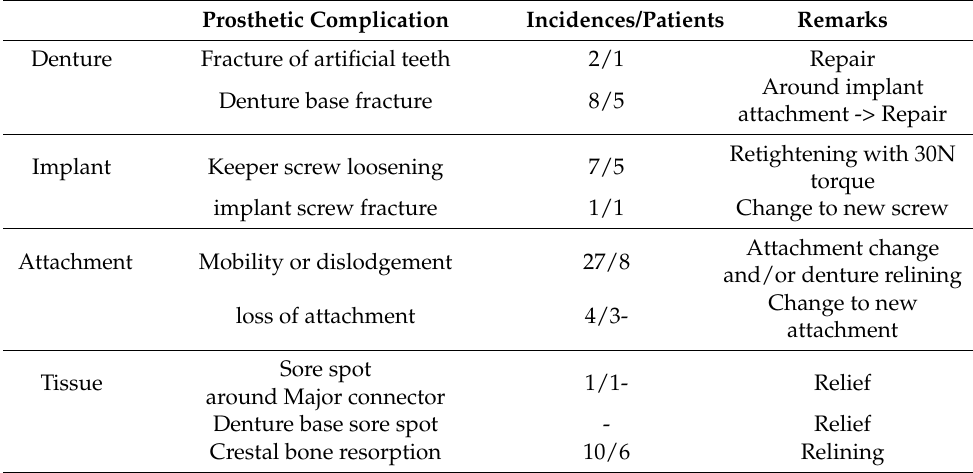
Table 8. Complications in IOD with magnet